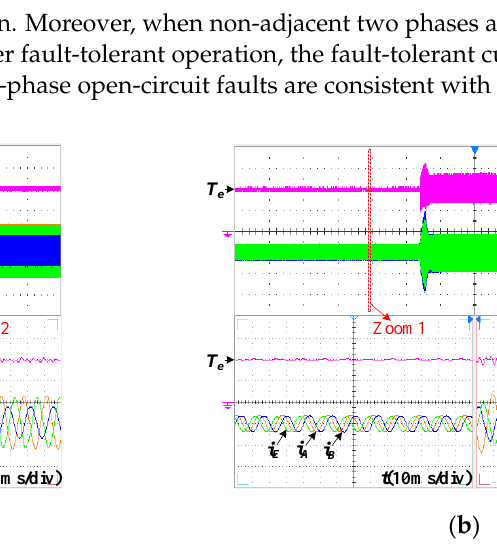
Figure 10. Dynamic responses with the reduced load at phase-A open-circuit fault-tolerant operation. (500 rpm/div, 2 Nm/div, 5 A/div).